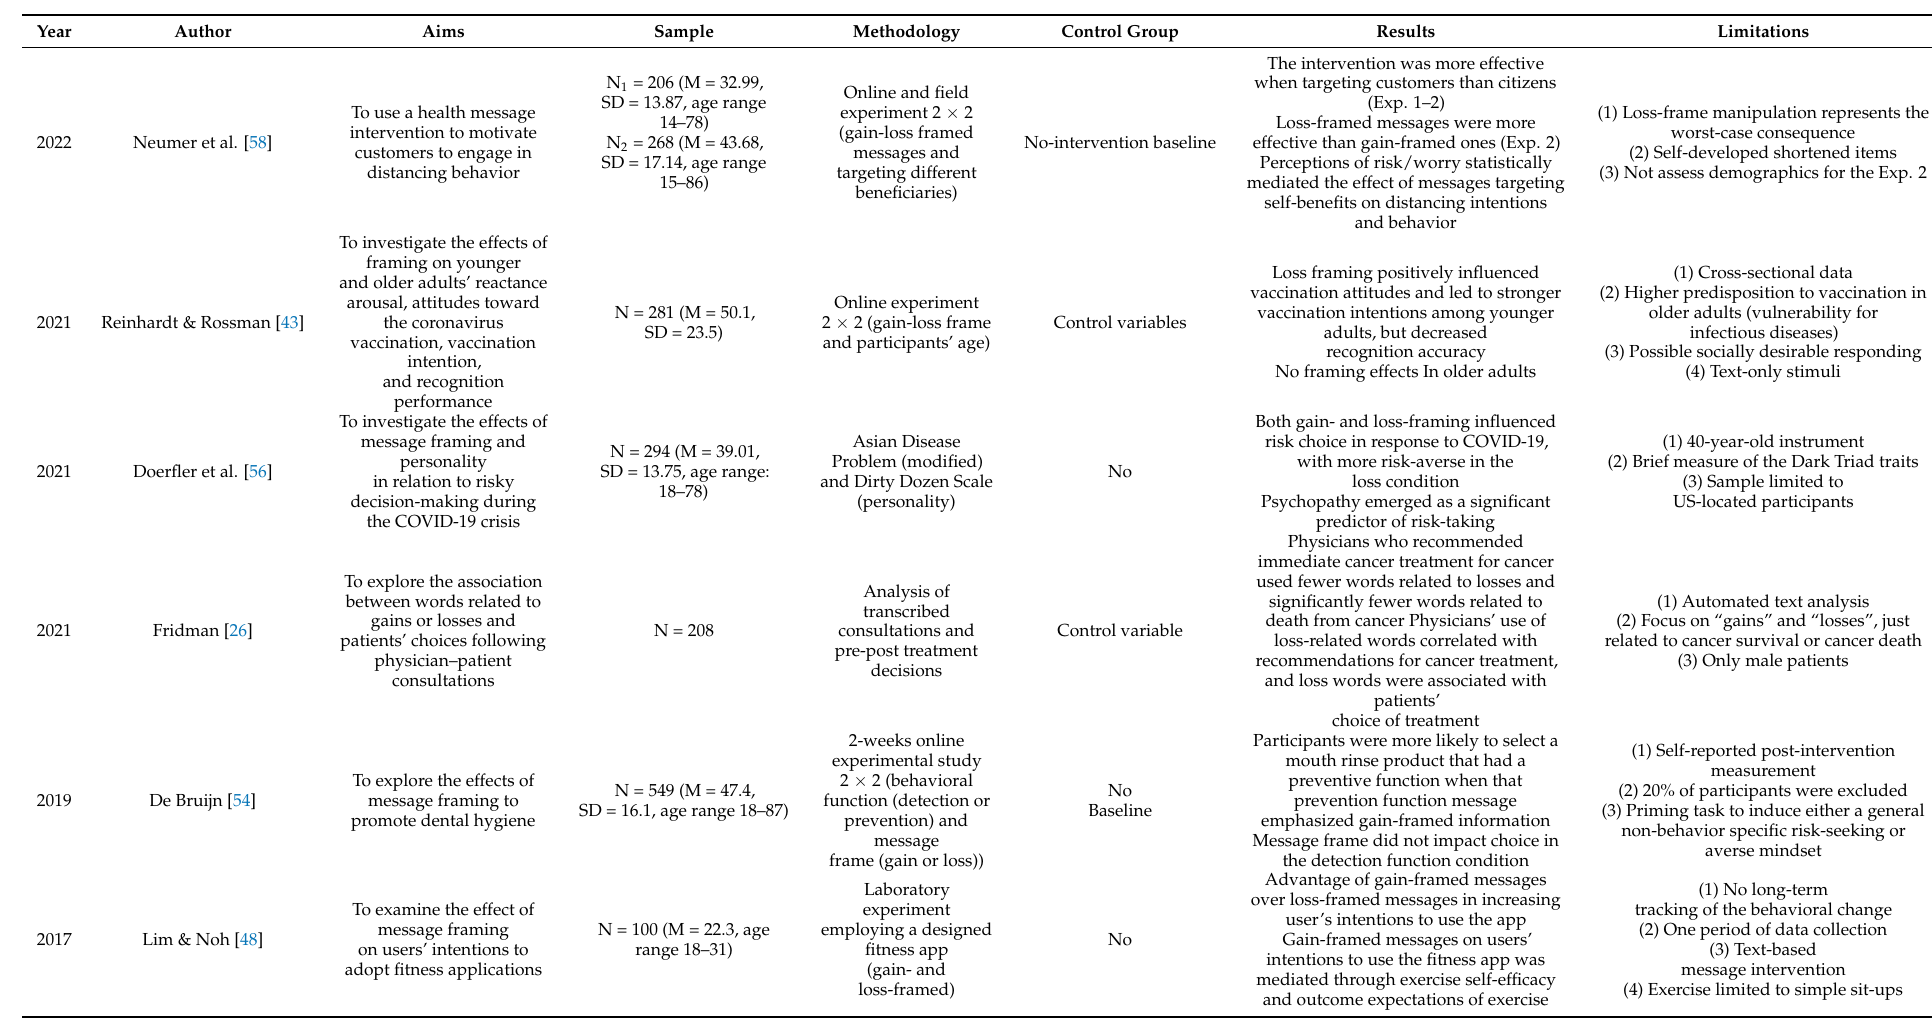
Table A2. Systematic data of empirical